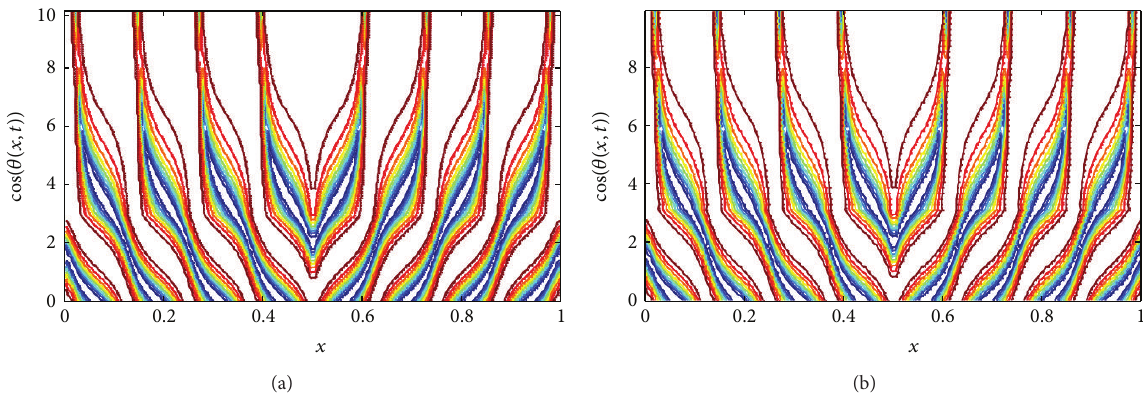
Figure 2: Here we present contour of cos (𝜃 ℎ (𝑥,𝑡)) for 0 ≤ 𝑥 ≤ 1 , 0 ≤ 𝑡 ≤ 10 . Here we use 𝑁 = 128 space nodes to compute the spatial integrals and then use various choices of Δ𝑡 for time integration. Here (a) backward Euler, (b) Trapezoidal method.